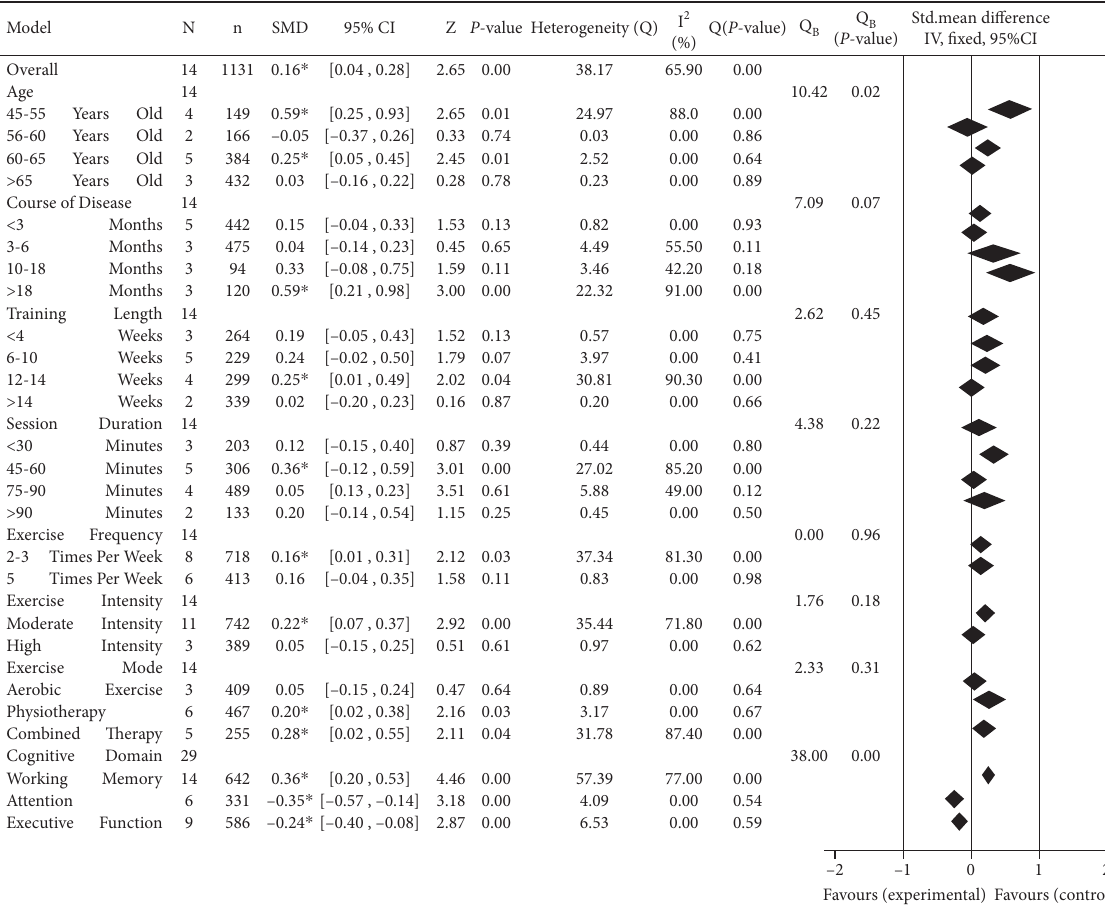
Figure 4: Effect sizes for each subgroup within the included